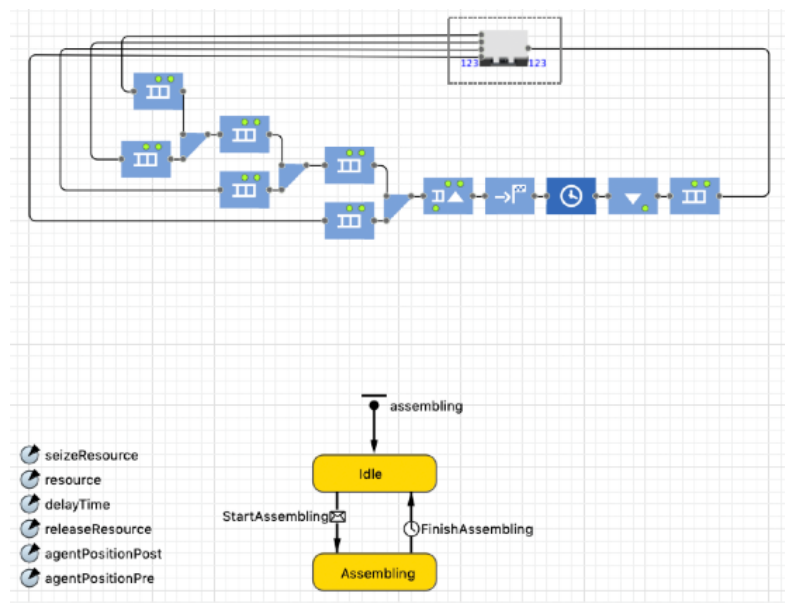
Figure 6. Assembly, Software: [10].